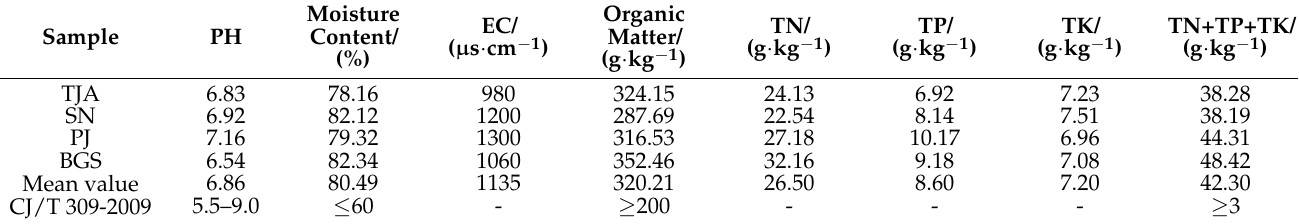
Table 3. Physicochemical characteristics of the sewage sludges.